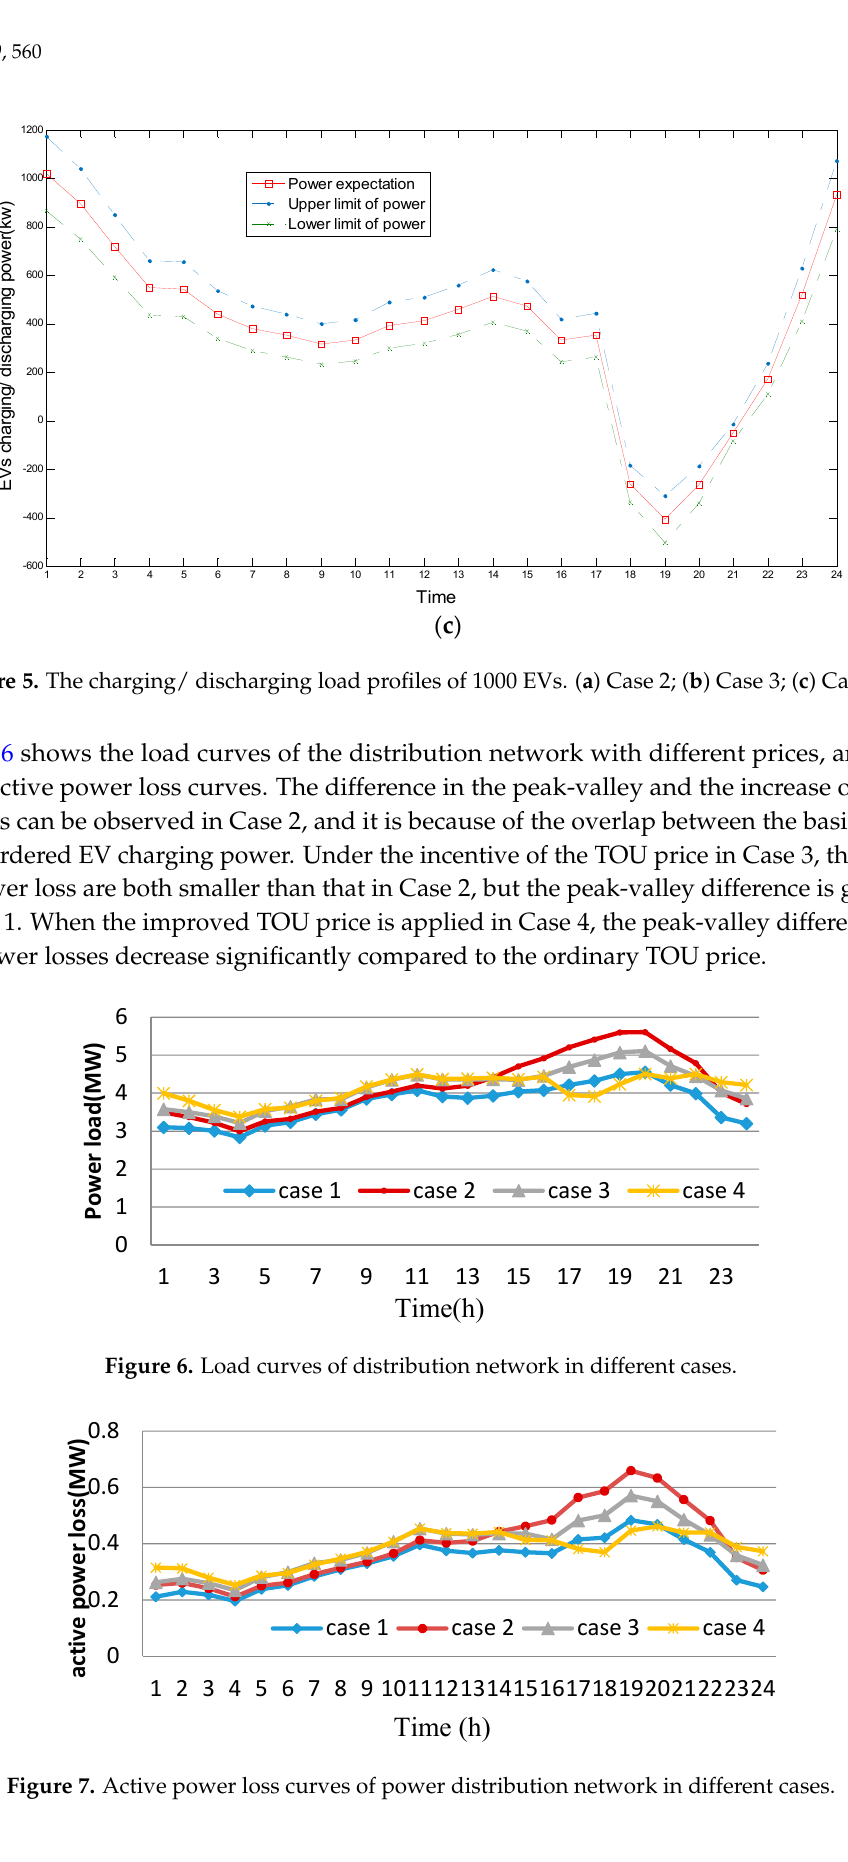
Figure 8. An IEEE 33 ‐ bus distribution network. Table 1. The number of EVs in each EV ‐ station. EV ‐ Station